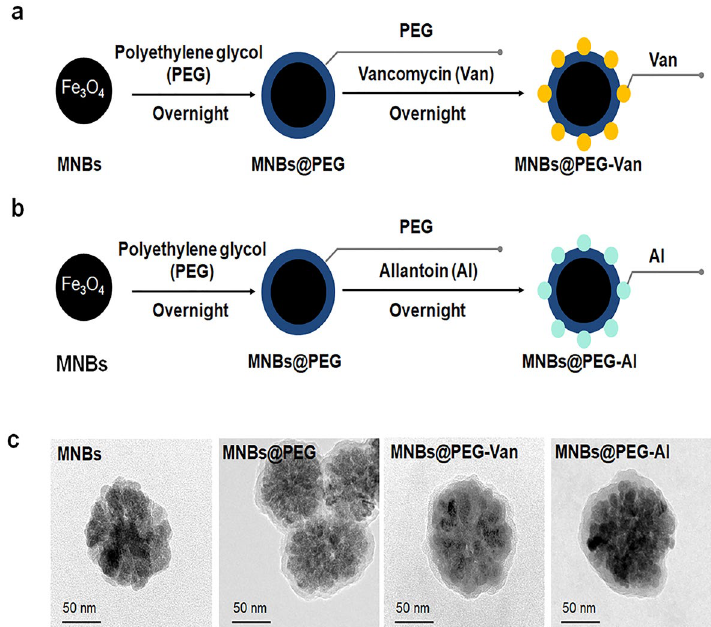
Figure 2. Conjugation of materials to MNBs (magnetic nanobeads). ( a ) Schematic of the synthesis of MNBs@ PEG-Van (polyethylene glycol-vancomycin). ( b ) Schematic of the synthesis of MNBs@PEG-Al (polyethylene glycol-allantoin). ( c ) TEM (Transmission electron microscopy) images of unconjugated MNBs, MNBs@PEG, MNBs@PEG-Van, and MNBs@PEG-Al.